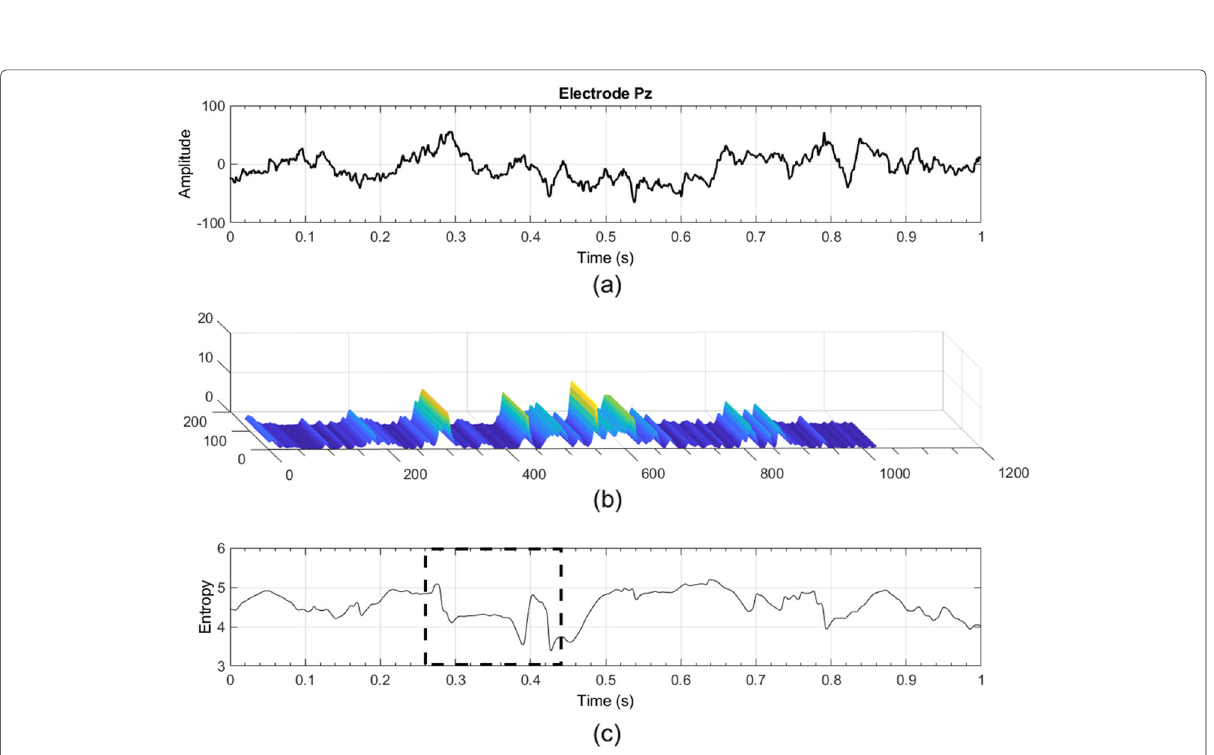
Fig. 16 Electrode Pz after RICI a Time domain representation of ERP b SPWVD time-frequency representation c short-term Rényi entropy of the